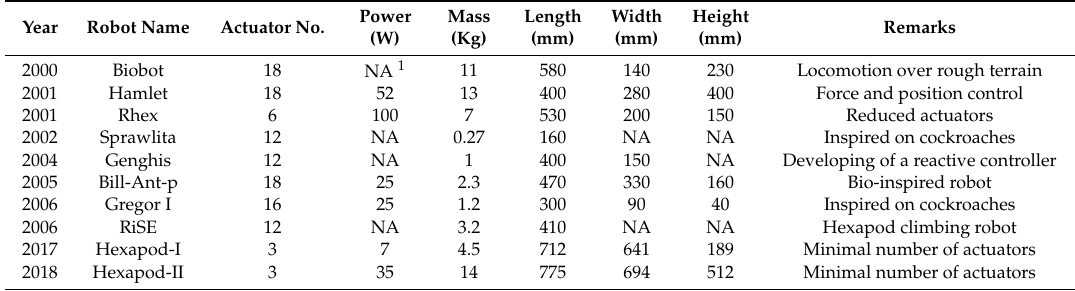
Table 4. A variety of hexapod robots.